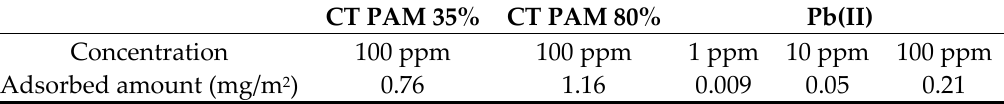
Table 1. The cationic polyacrylamide and Pb(II) ion adsorption